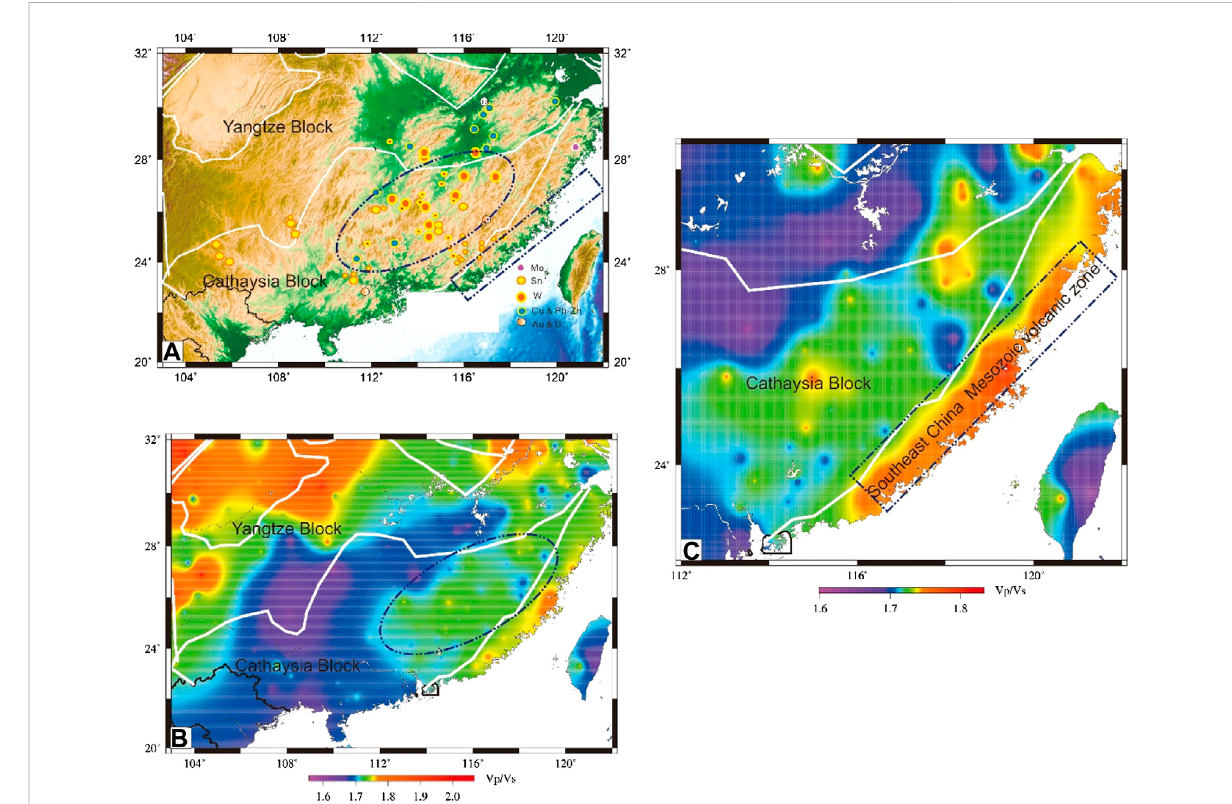
FIGURE 8 Regions with high Vp/Vs. ratios and metal deposits zones. The Mesozoic volcanic zone in Southeast China (the area with high Vp/Vs. ratios) (C, rectangle) corresponds with the continental margin metal deposit zone (Cretaceous Sn-W-Pb-Zn-Au-U system along the continental margin) (Fig. a, rectangle). Another area with high Vp/Vs. ratios (B, blue oval) corresponds with the Nanling metal deposit zone (Nanling belt and adjacent area, a granite-related W-Sn-Mo-Bi-Be system formed from 160 to 150 Ma) (a, blue